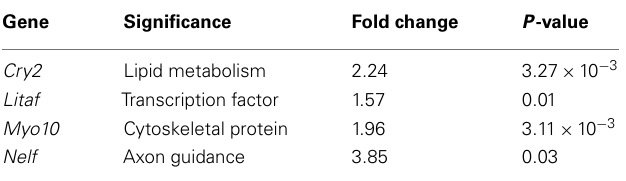
Table 3 | Genes differentially expressed in regions of induced young adult neurogenesis not previously studied in the neocortex, but expressed in the developmental neocortical ventricular zone, subventricular zone, and cortical